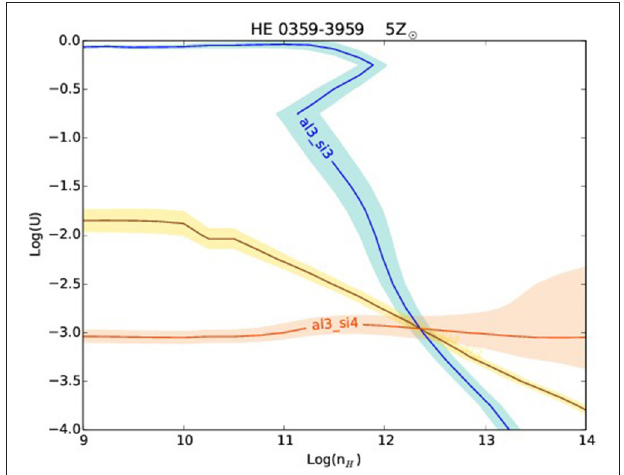
FIGURE 3 | Isocontors for HE0359-3959 with 5Z ⊙ and an overabundance of Al and Si. The blue line indicates the flux ratio Al III λ 1860/Si III ] λ 1892, the yellow one indicates the ratio Si IV λ 1397/Si III ] λ 1892, and the orange corresponds to the Al III λ 1860/Si IV λ 1397. Shadows associated with each line indicate the error. The flux ratios are intersected in n H · U = 9.27 ±